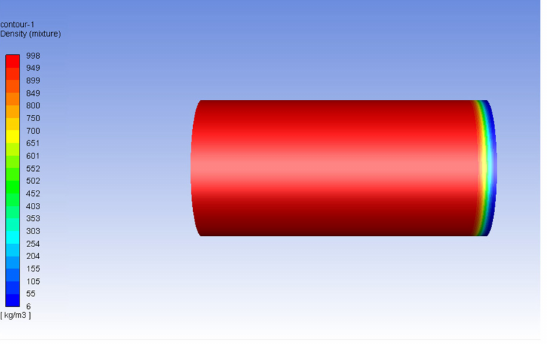
Figure 8. Density profile across the core—gaseous carbon dioxide inlet pressure 2.6 MPa.